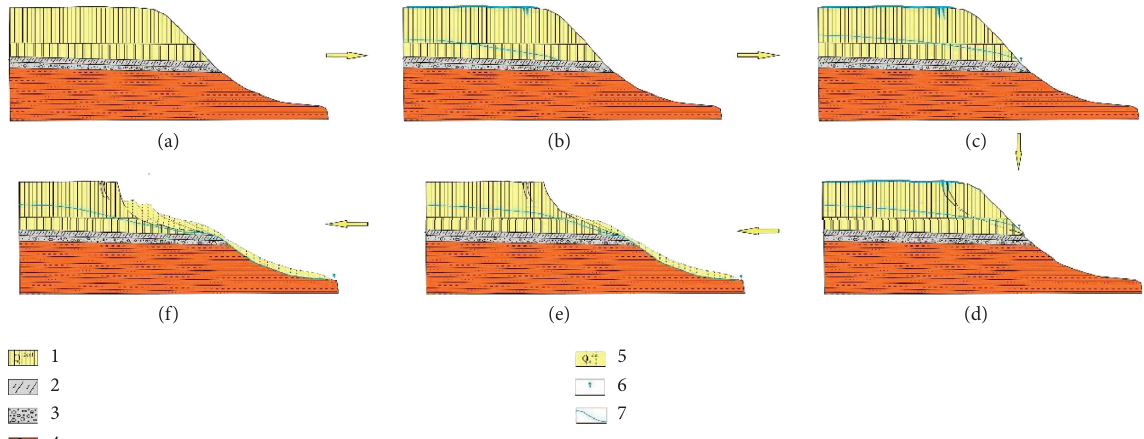
Figure 17: The failure mode of loess landslide induced by irrigation (1: loess; 2: silty clay; 3: sand and gravel; 4: sandy mudstone interbedding; 5: landslide deposits; 6: spring; and 7: groundwater